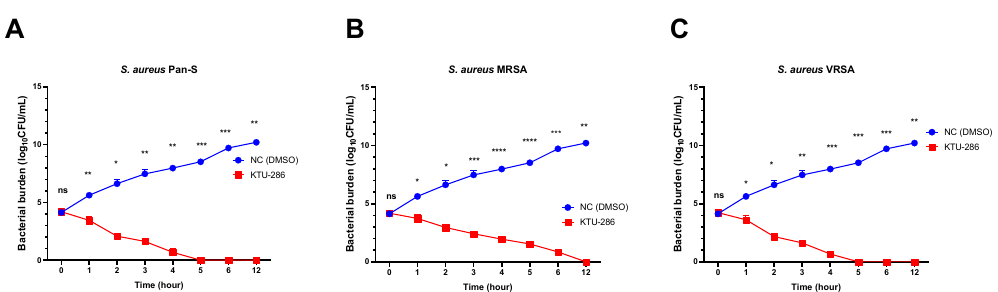
Figure 4. Time-kill kinetics of Staphylococcus aureus , showing bactericidal activity of KTU-286 against strains with genetically defined resistance. The Pan-S Staphylococcus aureus ( A ), MRSA ( B ), and VRSA ( C ) were exposed to MICs of KTU-286 (4.0, 8.0, and 4.0 µg/mL respectively). A significant reduction ( p < 0.05) in S. aureus bacterial burden was observed among all S. aureus isolates used, without dependence on resistance mechanisms, when bacteria were exposed to the test compound for 12 h. Data represent mean ± SD of triplicate experiments ( n = 3). Statistical differences were determined using two-way ANOVA test. * p <0.05; ** p <0.01; *** p <0.001; **** p <0.0001.